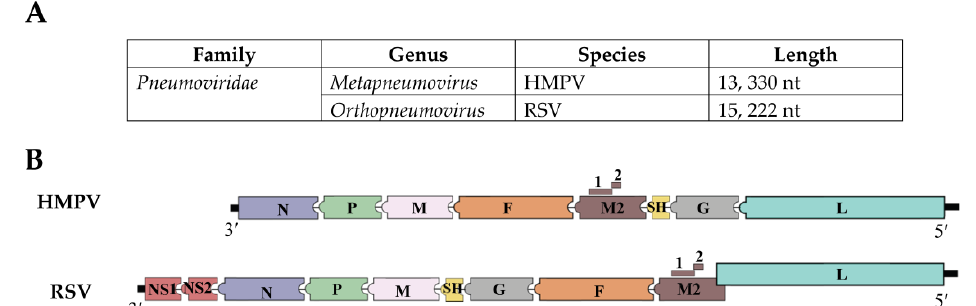
Figure 1. HMPV and RSV genomic configuration and the proteins they encode. ( A ) HMPV and RSV are negative sense single stranded RNA viruses and are members of the family Pneumoviridae . HMPV belongs to the genus Metapneumovirus , while RSV belongs to Orthopneumovirus genus; ( B ) Both viruses differ in the organization of the genomic proteins. Besides, the M2 and L proteins of RSV overlap by 68 nucleotides [16]. Another important difference between the viruses is that RSV genome encodes additional two proteins, non-structural proteins NS1 and